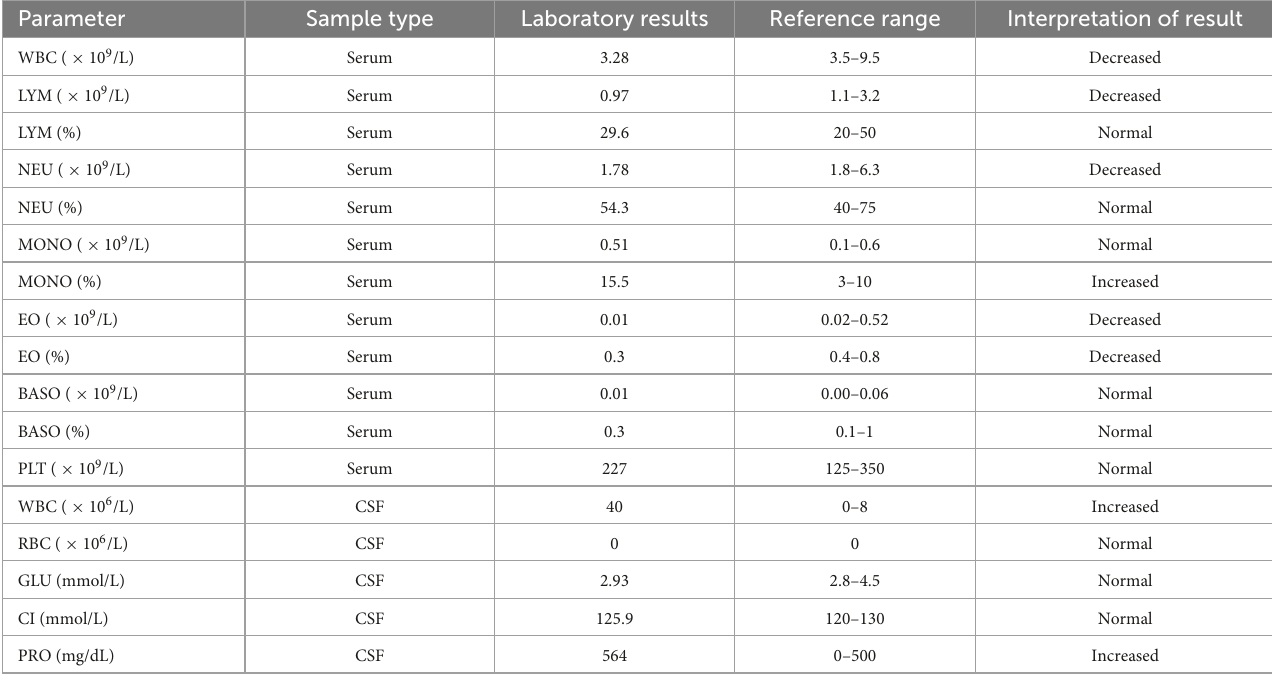
TABLE 1 Laboratory results of the serum and cerebrospinal